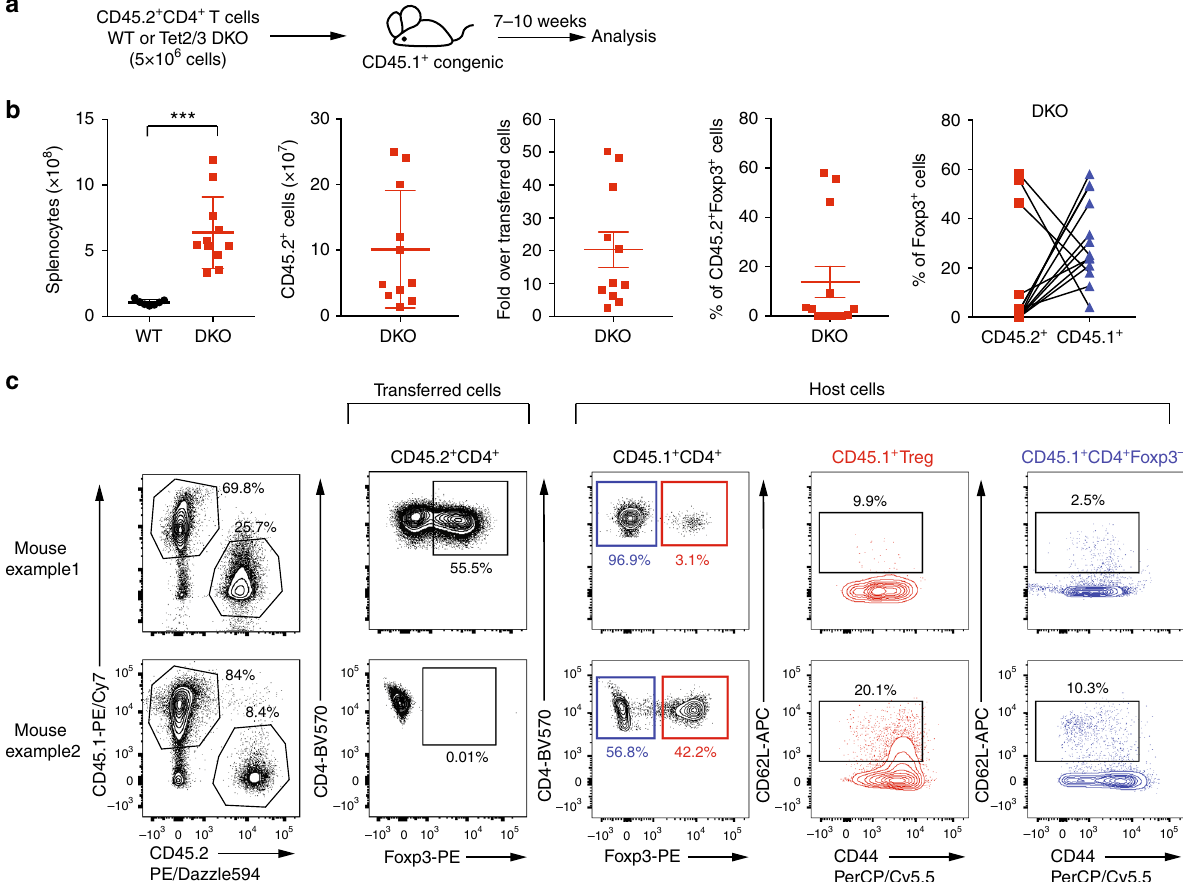
Fig. 7 Transfer of total CD4 + T cells from Tet2/3 fl / fl Foxp3 Cre mice elicits disease in healthy mice. a Schematic illustration for the transfer of total CD4 + T cells (5 × 10 6 cells) from WT or Tet2/3 fl / fl Foxp3 Cre DKO mice (14 weeks old) into immunocompetent congenic recipient mice ( n = 11 recipient mice), the mice were analyzed 7 – 10 weeks after transfer. b From left to right, the graphs show the numbers of total splenocytes and of transferred and expanded CD45.2 + cells, the fold increase in the number of transferred and expanded DKO CD45.2 + cells, the percentage of Foxp3 + cells in CD45.2 + cells after transfer, and the percentage of Foxp3 + cells in CD45.2 + and CD45.1 + cells in each individual with connection lines. c Representative fl ow cytometry analyses of the percentage of CD45.2 + T cells, the percentage of Foxp3 + cells in CD45.2 + cells (example 1 showing an expansion of Foxp3 + cells, example 2 showing a loss of Foxp3 + cells), the percentage of Foxp3 + cells in CD45.1 + host cells, CD62L and CD44 expression in host Treg cells and CD4 + Foxp3